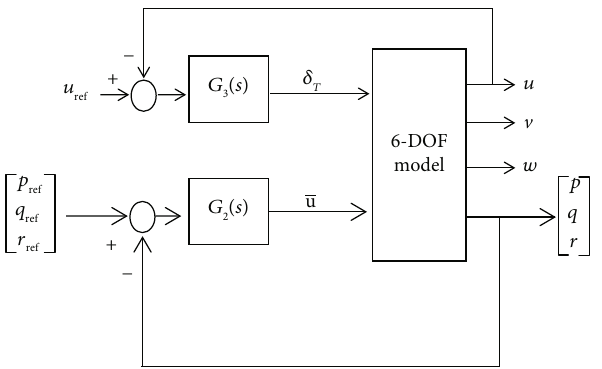
Figure 8: Block diagram of the RCRH system and SCSH system.